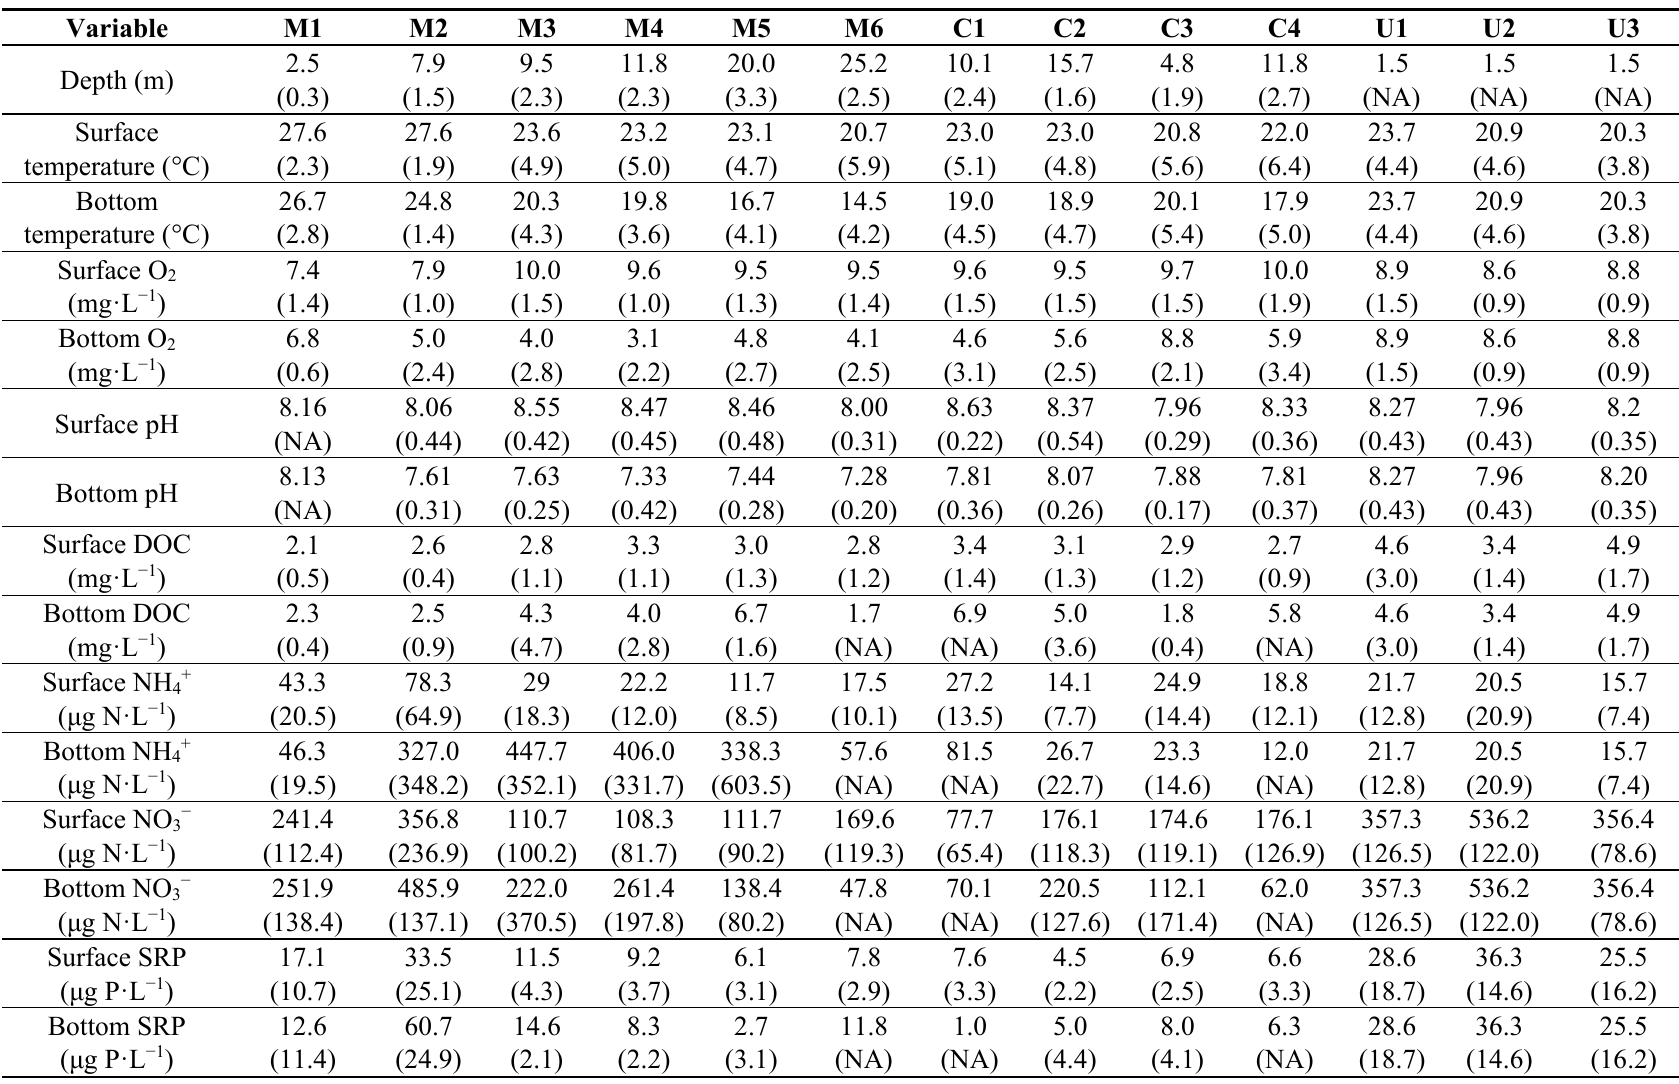
Table 2. Spatial variation in physicochemical variables of Douglas Lake. Values are sample averages with 95% confidence intervals in parentheses. Confidence intervals for sample averages represented by a single sample ( i.e. , no seasonal replication) are denoted with